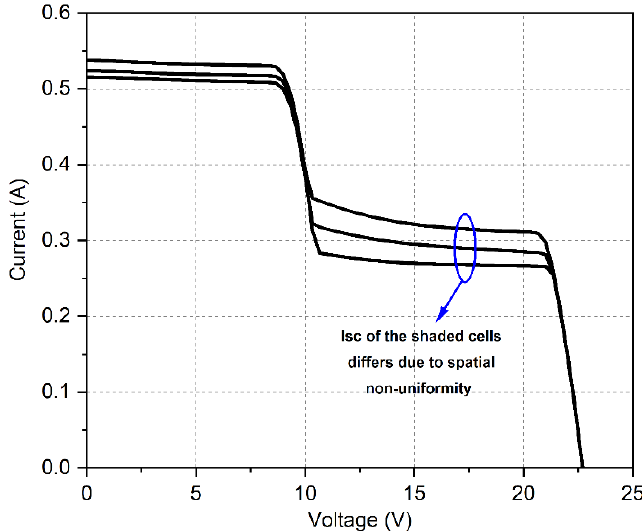
Figure A2. I-V curves of the 10 W PV module under 50% shading of three different cells. The figure shows that the spatial non-uniformity affects only the current of the shaded cell represented in the height of the horizontal part between about 11 and 21 V. It does not significantly affect the shape of the I-V curve. Each I-V curve is the average of three measurements under a light irradiance of 1000 W/m² measured at the centre of the module at a module temperature of 40 °C.